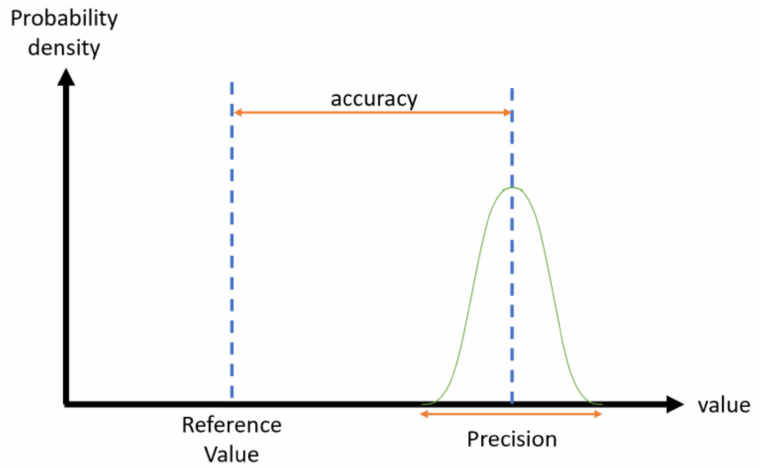
Figure A4. Sensor accuracy and